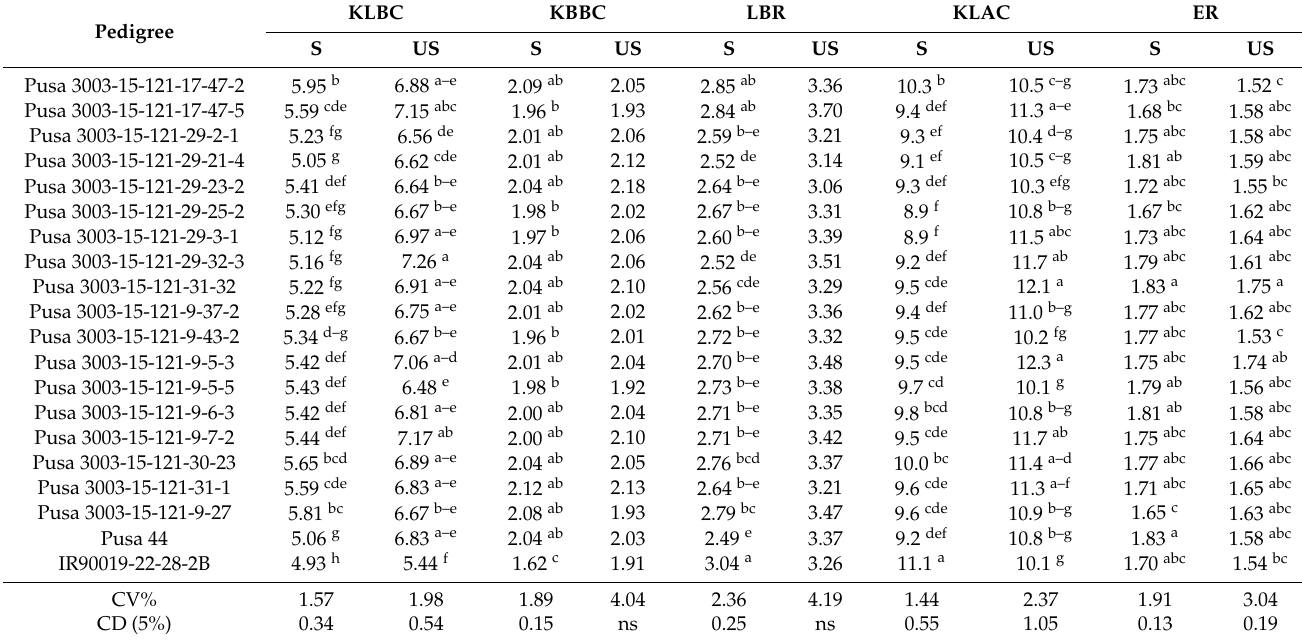
Table 7. Grain quality data for Pusa 44 qDTY12.1 NILs under stressed and unstressed treatments.